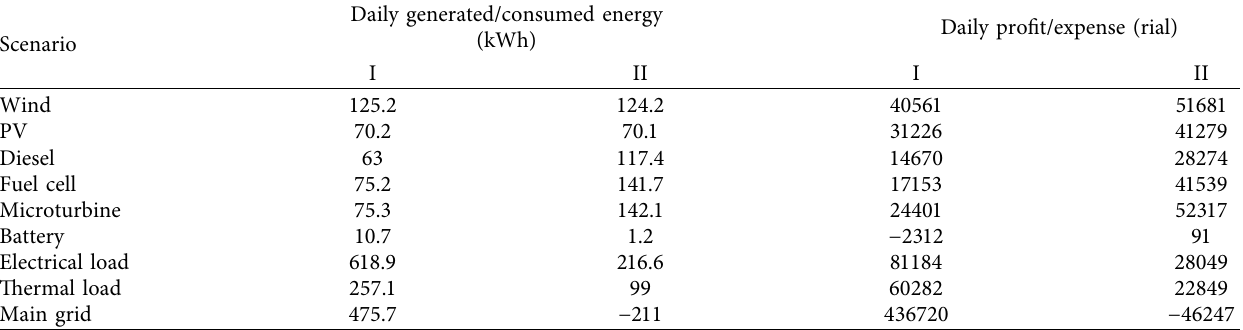
Table 2: Te average results of EMS based on decentralized reinforcement learning over 800days.